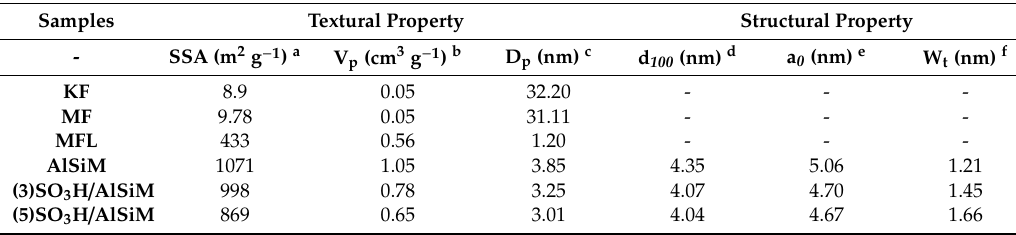
Table 2. Textural and structural